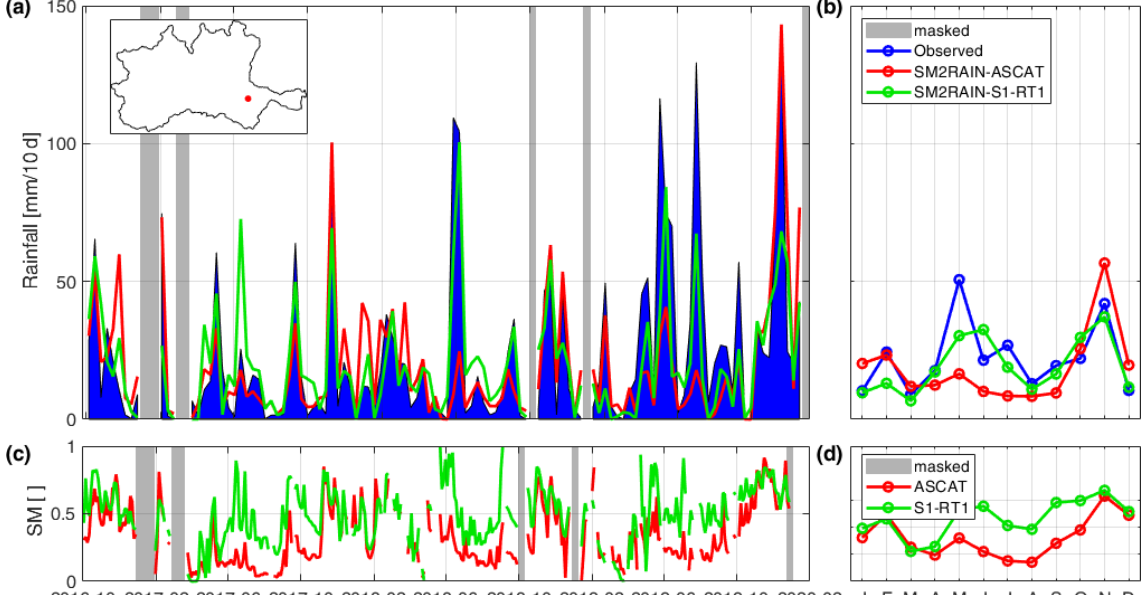
Figure 7. Example of SM and rainfall time series over a pixel (10.684 ◦ E 44.805 ◦ N) selected in the plain. In (a) , the time series of the observed (blue) and estimated (red SM2RAIN-ASCAT, green SM2RAIN-S1-RT1) 10d accumulated rainfall products are shown, while panel (c) displays SM time series averaged with a 3d window. Finally, panels (b) and (d) contain the standard month average of the rainfall and SM products, respectively. The periods masked for frozen soil conditions or snow cover are highlighted in